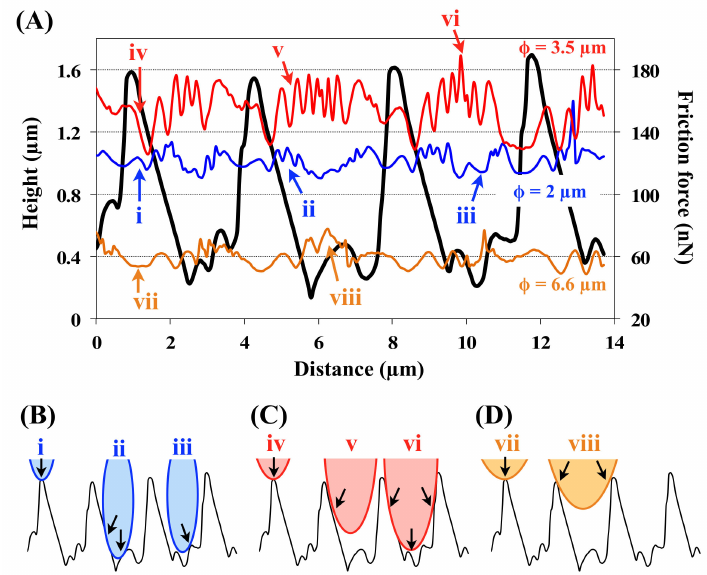
Figure 7. Graph and schematic illustrations showing the relationship between groove structures, friction force and colloidal probes. ( A ) Height profiles of the groove structures (black line) and friction forces (colored lines). The data were selected from the white lines on the friction force images in Figure 4. ( B – D ) Schematic of the relationship between groove structures and the ( B ) 2, ( C ) 3.5, and ( D ) 6.6 µ m diameter colloidal probes. Black arrows indicate the contact area between groove structures and colloidal